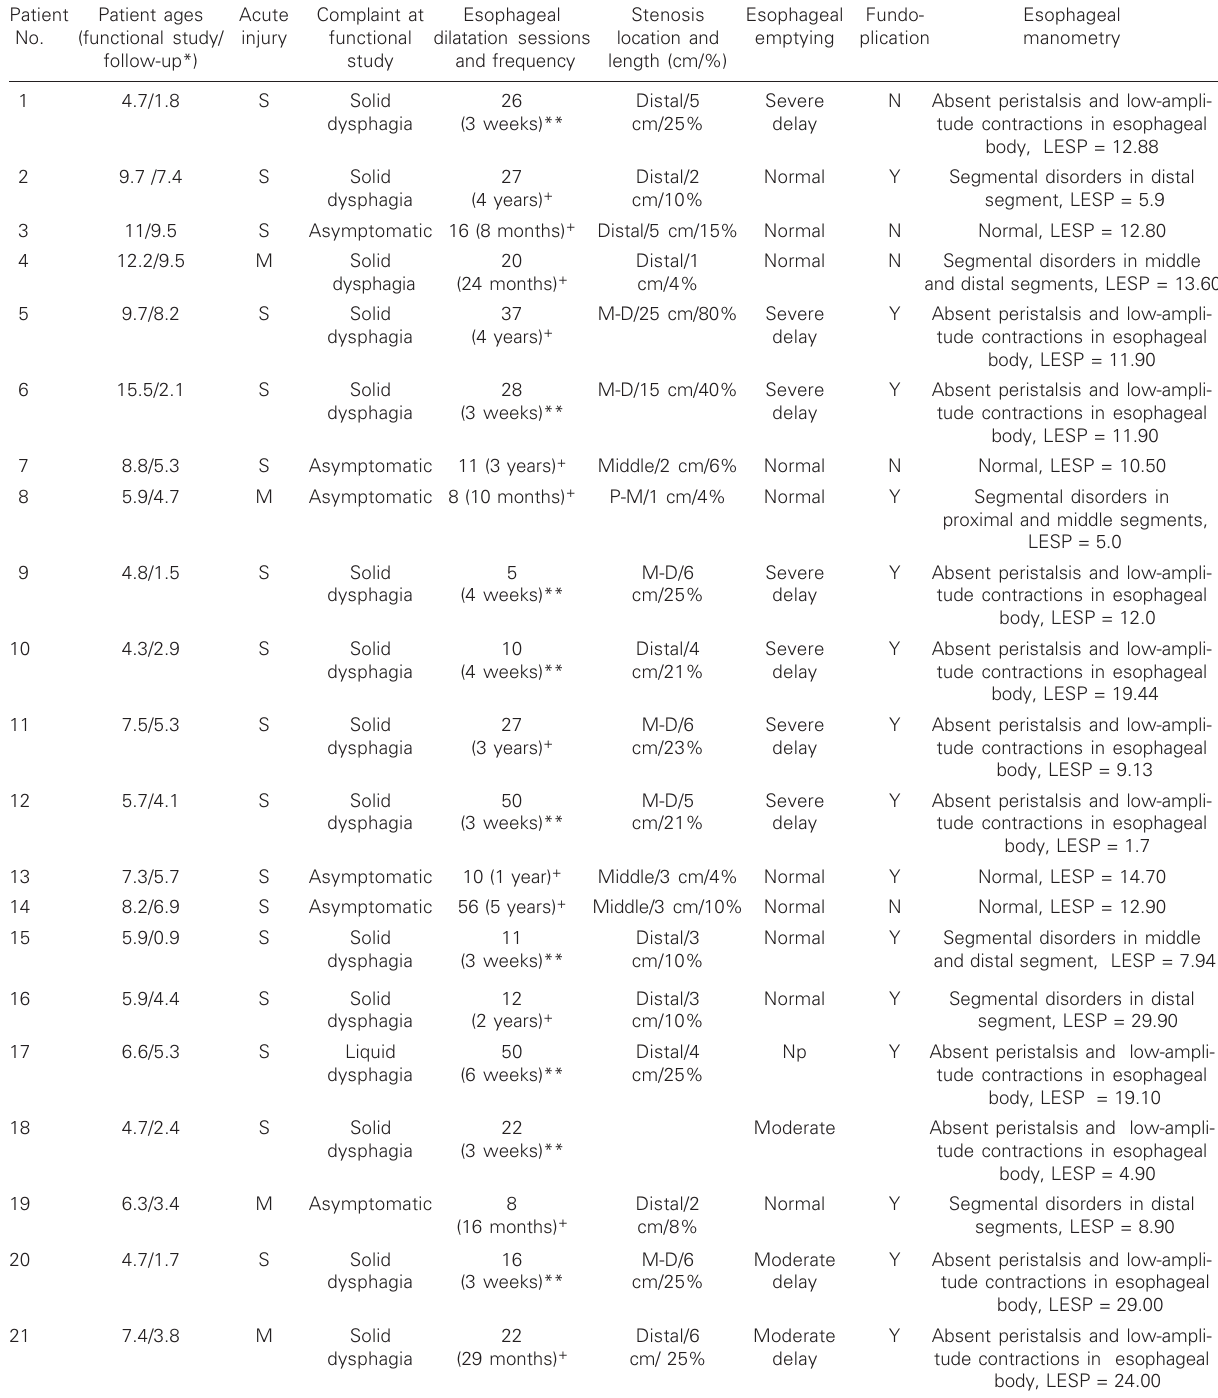
Table 1. Clinical data for 21 patients presenting esophageal strictures caused by sodium hydroxide ingestion.